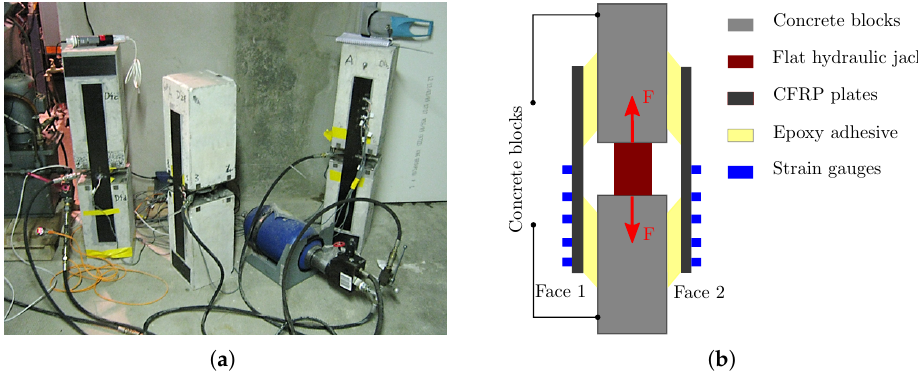
Figure 4. Creep test setup on double shear specimen previously proposed by Houhou et al. [17,45]. ( a ) Picture of the experimental setup, ( b ) principle of the test and loading